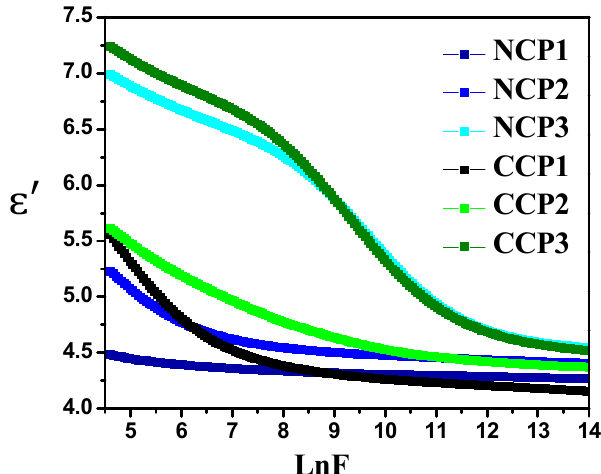
Figure 9. Variation in real part of permittivity with varying concentrations of nanofillers at different frequencies.